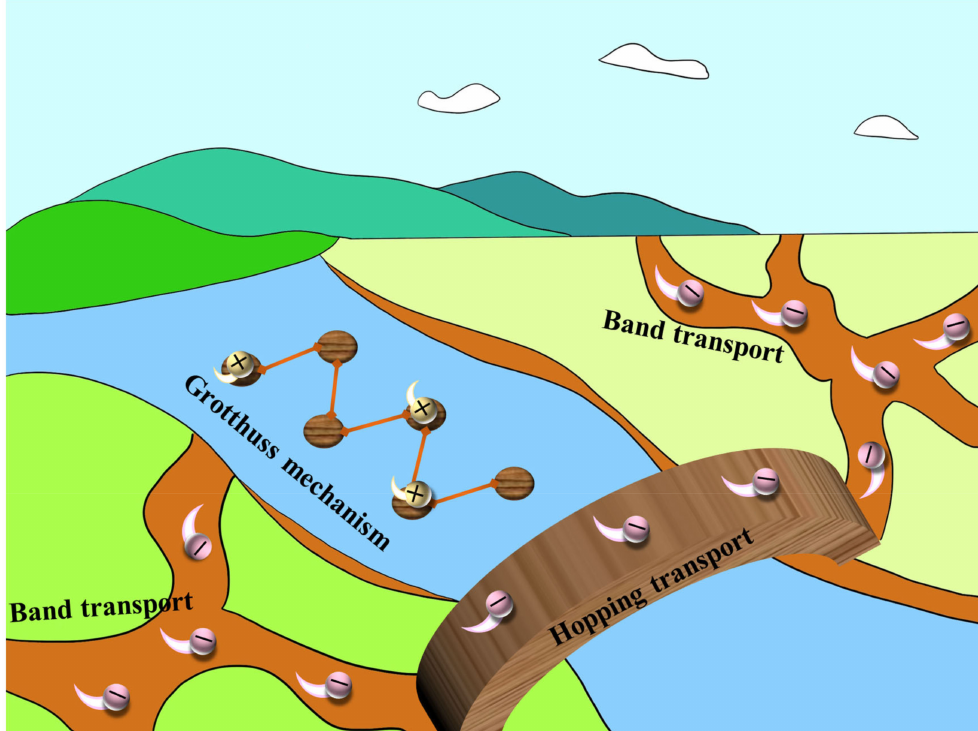
Figure 4. Three conductive mechanisms of